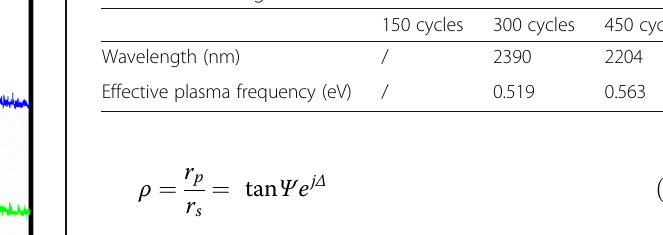
Table 2 Wavelength when the real part of epsilon of AZO thin films is zero in Fig.